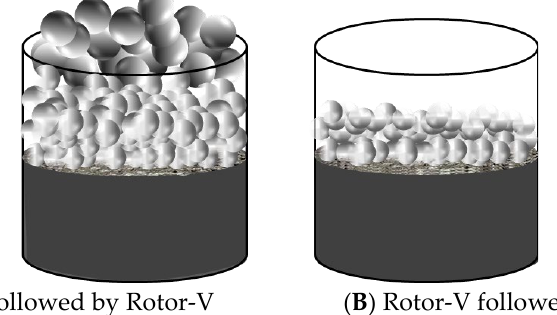
Figure 5. The phenomenon of two-stage HSS for oily sludge cleaning. (( A ) Rotor-C followed by Rotor-V; ( B ) Rotor-V followed by Rotor-C).